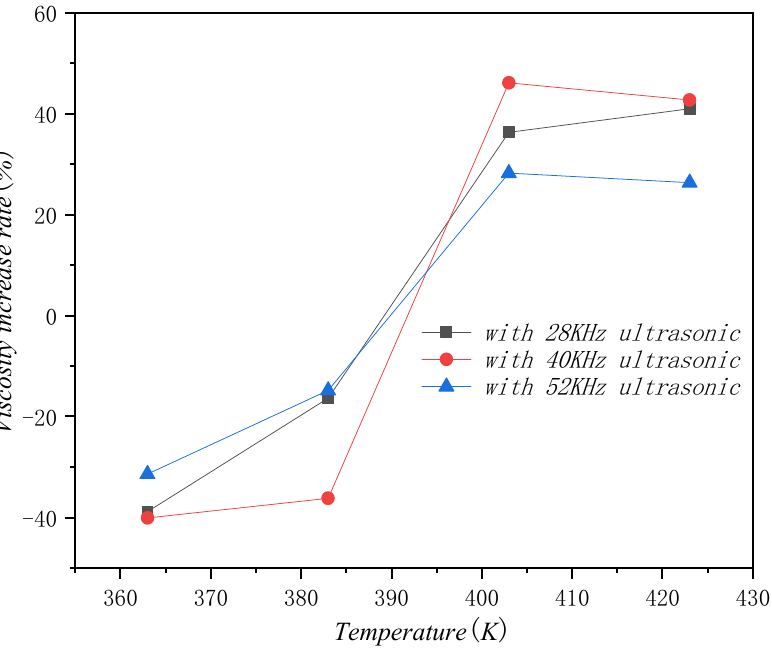
Figure 13. Ultrasonic effect of modified asphalt viscosity increase rate with temperature frequency change curve.